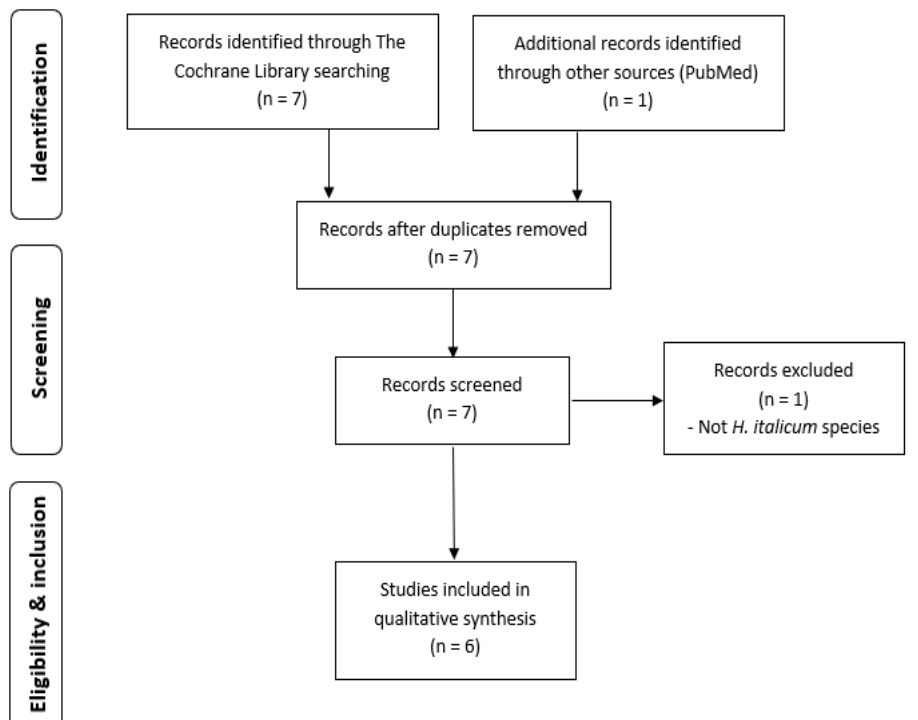
Figure 2. Flowchart of the trials’ selection process. n—number of records/studies.